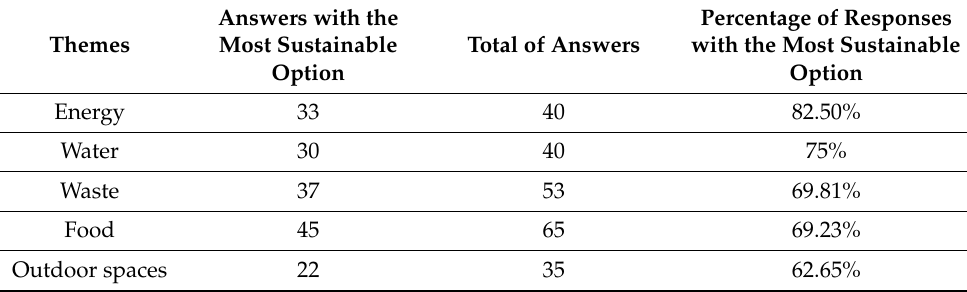
Table 3. Sustainability Audit responses on the Eco-Schools Programme.